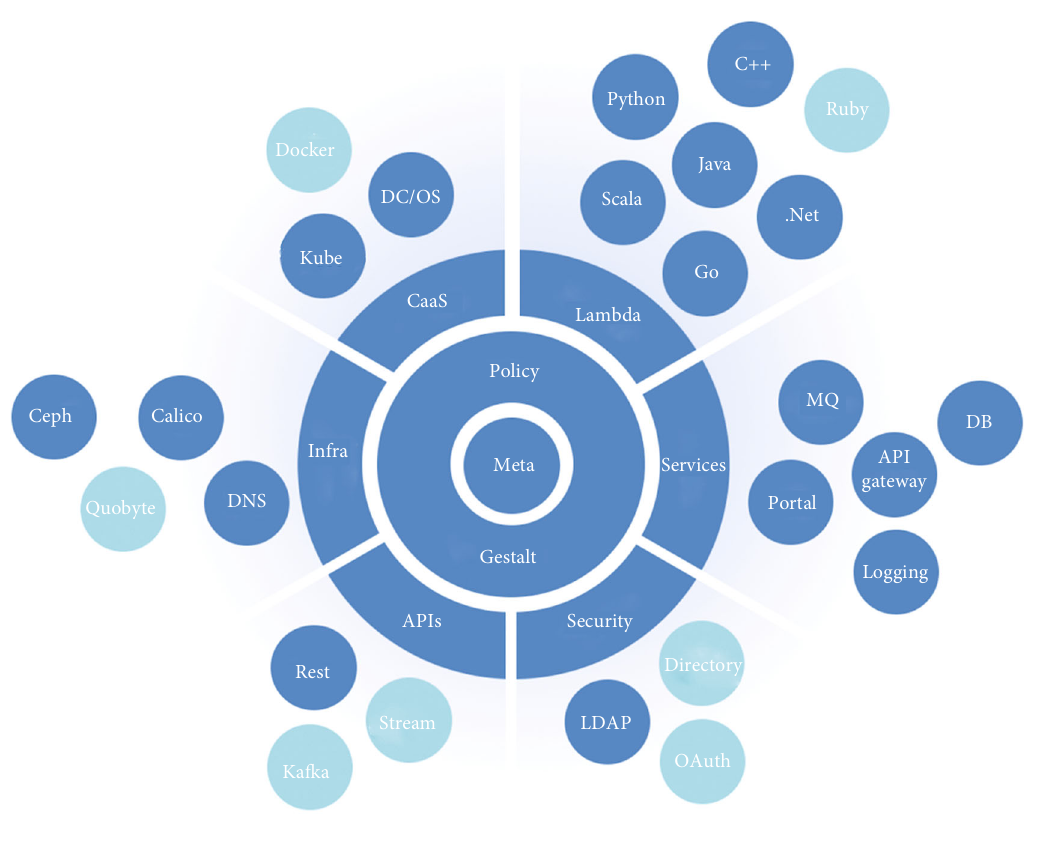
Figure 1: Gestalt theory